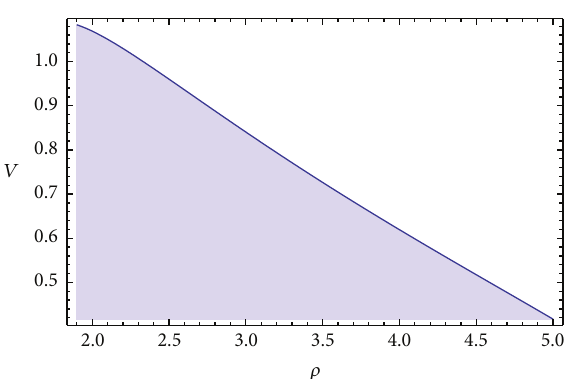
Figure 9: Solid curved line represents the minimum velocity required to escape from the ISCO. We have plotted the escape velocity ( V esc ) for 𝑏 = 0.9 and ℓ = 1.5 .